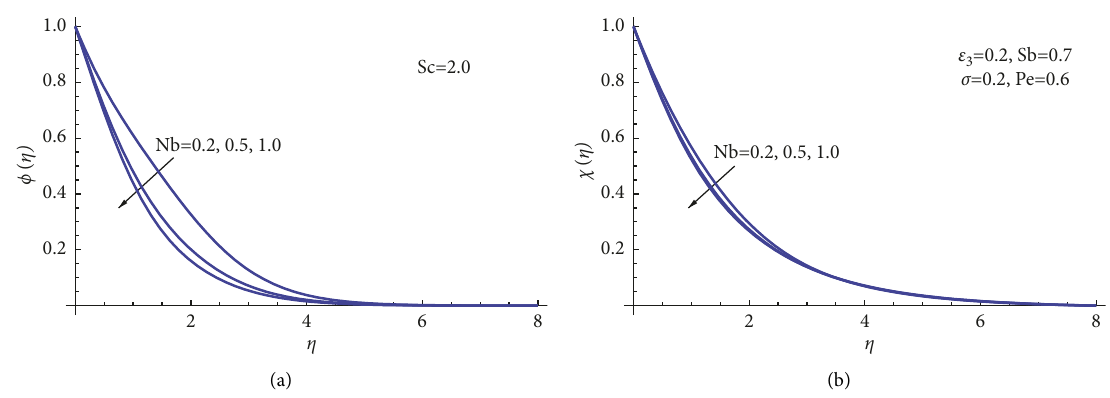
Figure 9: (a) Impact of Nb on ϕ ( η ) . (b) Impact of Nb on χ ( η )